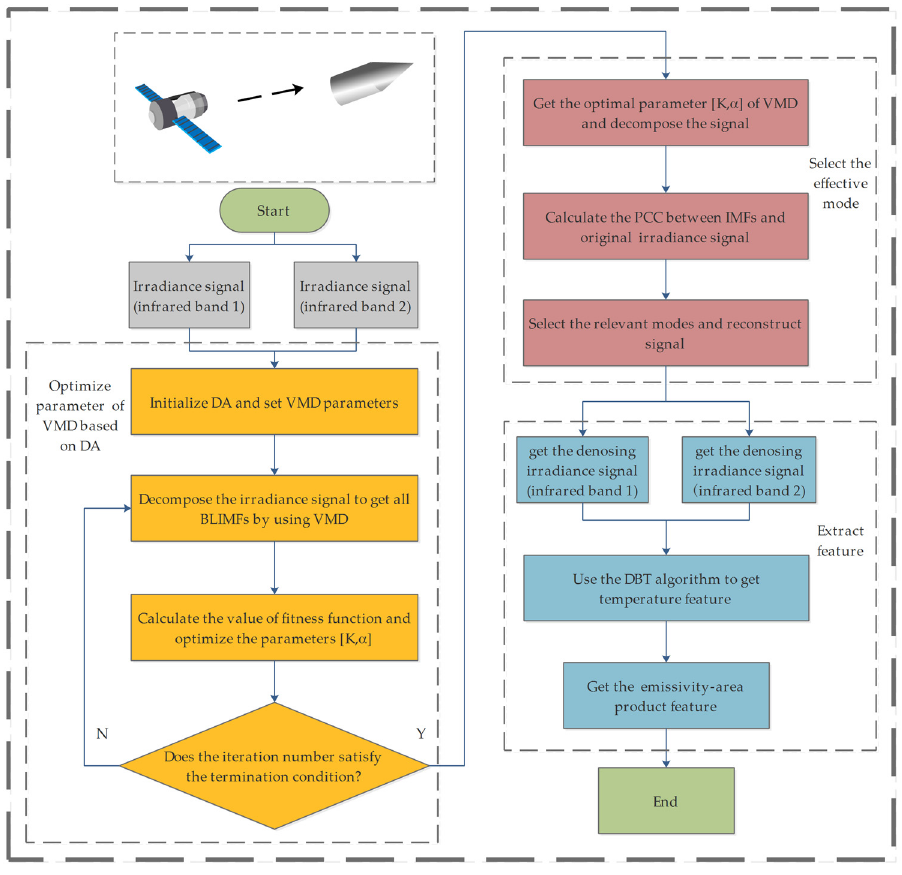
Figure 2. Flowchart of the proposed